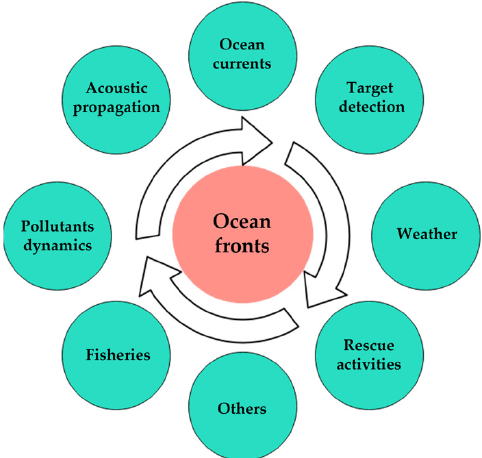
Figure 1. Influences of the ocean front in the world’s oceanic and atmospheric